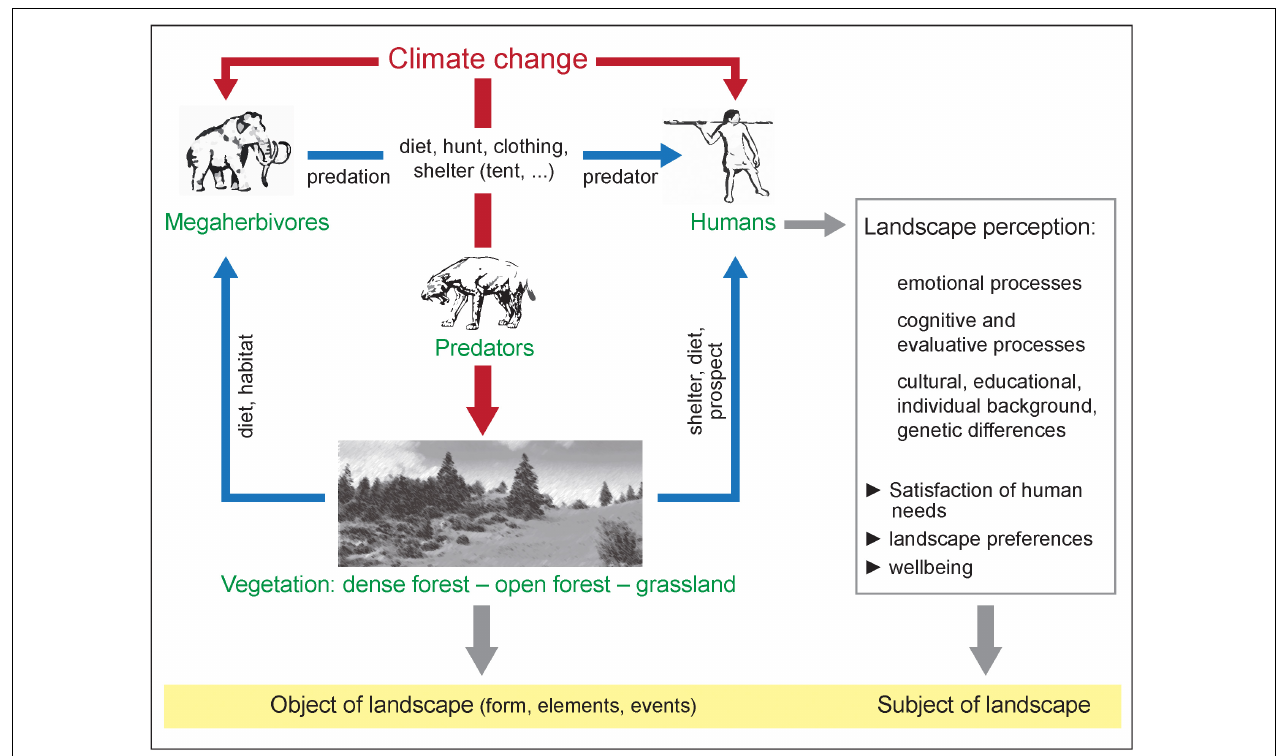
FIGURE 1 | The simplified depiction of the interactions of mankind, climate change, the impact of mega herbivores on the landscape structures and the subjective perception of landscape. The focus is on the interactions between climate and the biosphere with human forcings affecting the environment and actively shaping their environment. Source: Winfried Weber, Institute of Geography and Geology, University of Würzburg, 2022. Reproduced with permission.